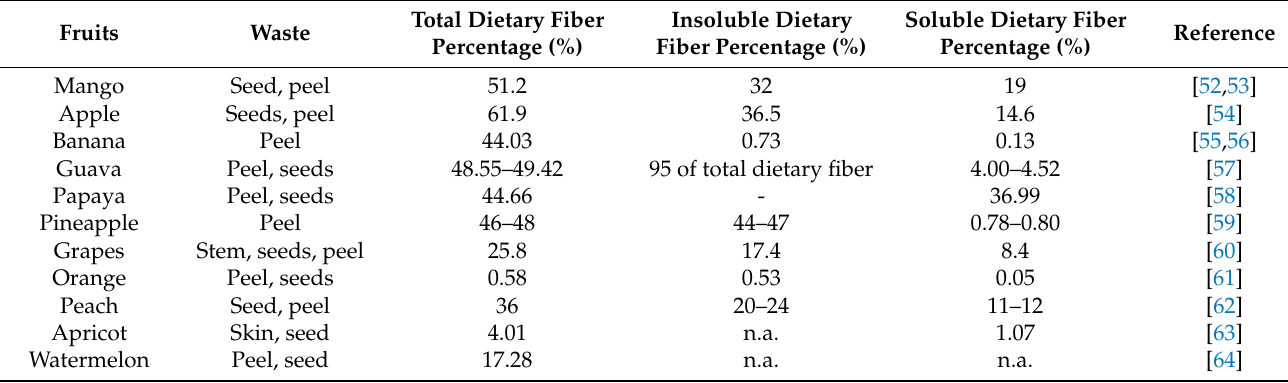
Table 2. Percentage of dietary fiber content in different fruits